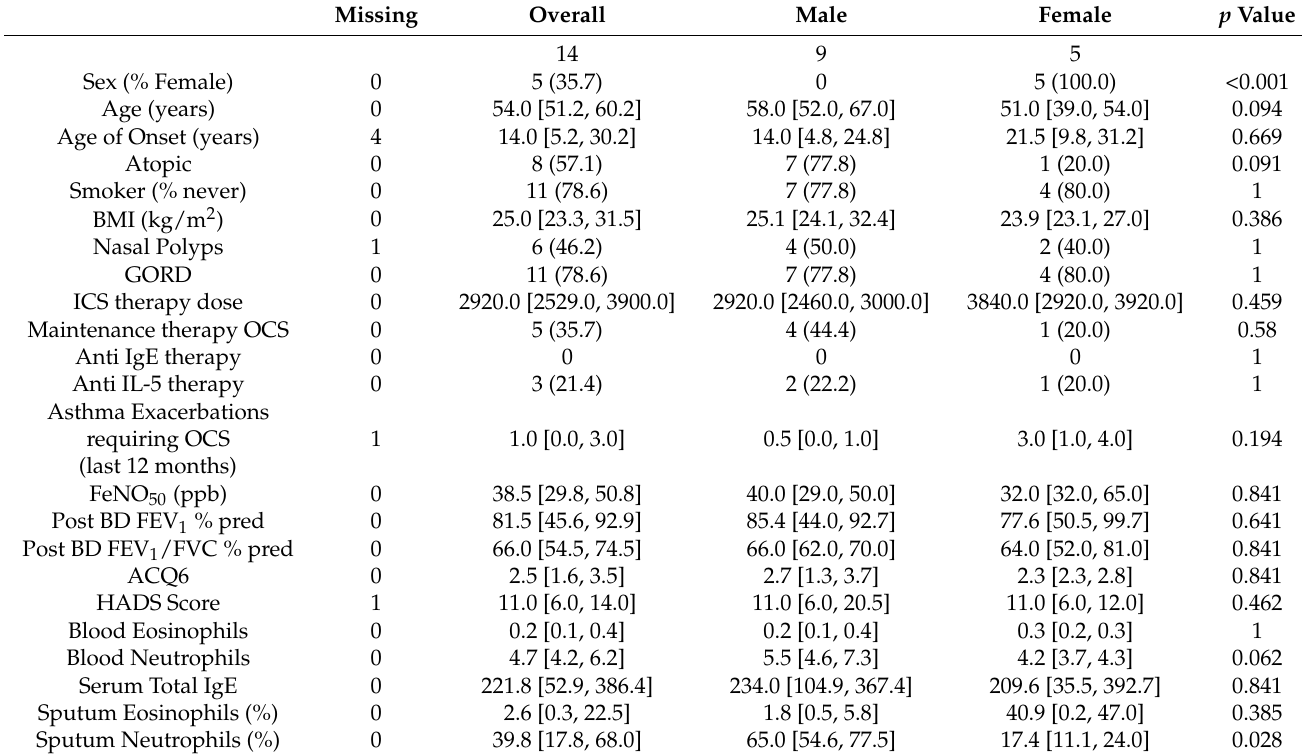
Table 1. Cohort characteristics by sex. Body mass index (BMI), gastro oesophageal reflux disorder (GORD), inhaled corticosteroids (ICS), oral corticosteroids (beclomethasone dipropionate equivalent) (OCS) immunoglobulin E (IgE), interleukin—(IL-5), fraction of exhaled nitric oxide (FeNO), parts per billion (ppb), forced expiratory volume in 1 s (FEV1), ratio between forced expiratory volume in 1 s and forced vital capacity (FEV 1 /FVC), measure relative to predicted value (% pred), asthma control questionnaire (ACQ6), hospital anxiety and depression scale questionnaire (HADS), Sino-nasal outcome test (SNOT22). Values displayed as number (%) or median [Q1,